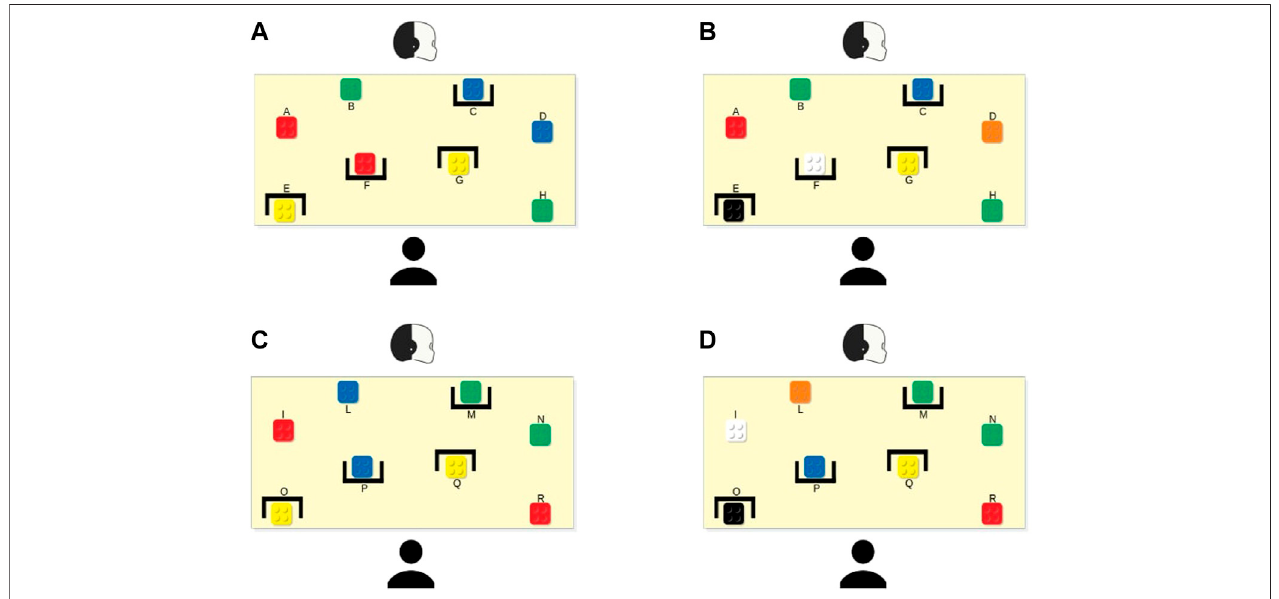
FIGURE 2 | The four bricks ’ setups used in the experiments. Setups (A,B) and (C,D) are equivalent, respectively, meaning that, even if it seems that they are different, they include bricks with the same value in the same position (red and white bricks, and black and yellow ones have the same value).